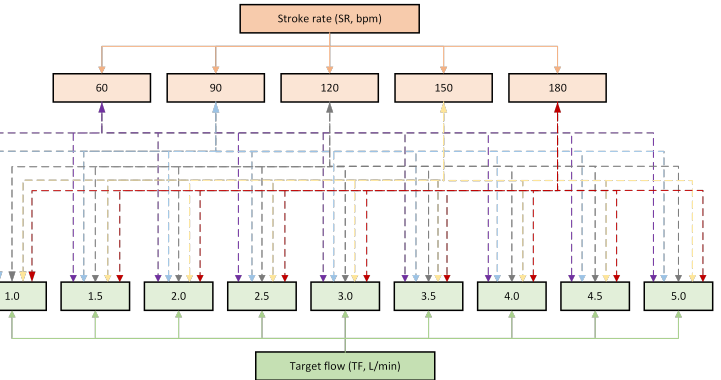
Figure A3. Diagram of the factorial analysis performed, where 2 factors, stroke rate (SR) and target flow (TF), were considered, as well as their interactions (discontinuous lines).